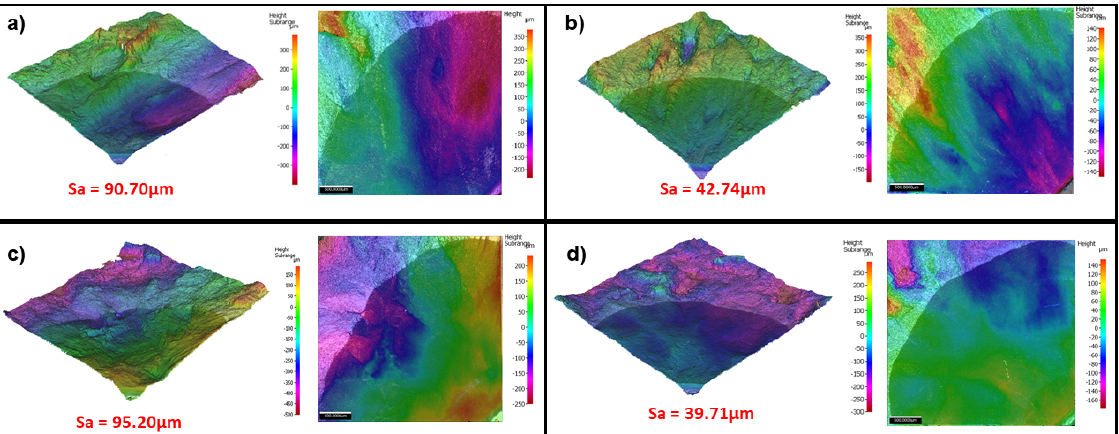
Figure 13. Profilometry of TMFCG fracture surfaces: ( a ) IP 200 − 500 °C ( b ) OP 200 − 500 °C ( c ) IP 200 − 550 °C and ( d ) OP 200 − 550 °C.